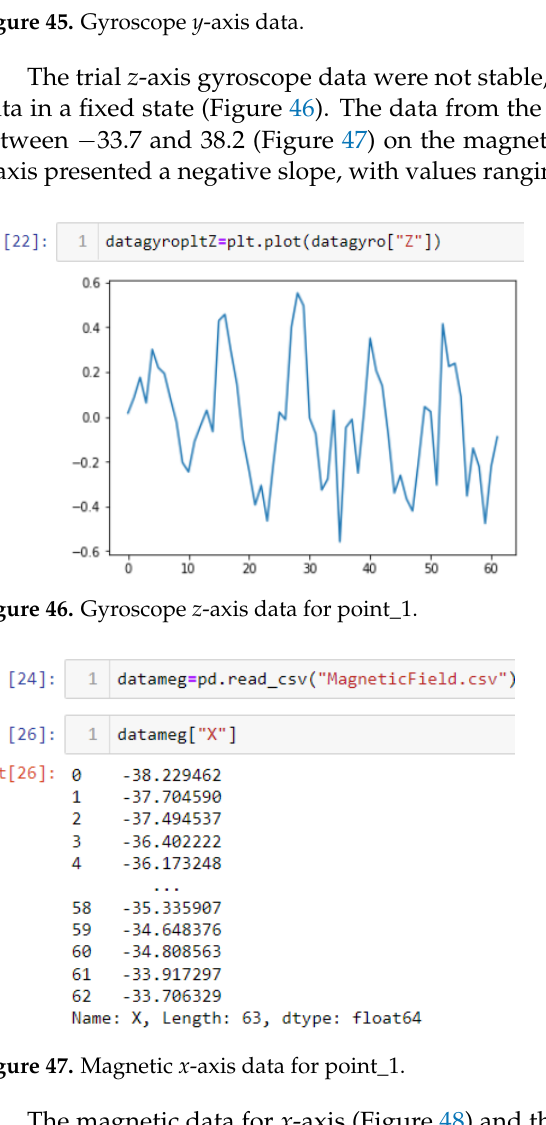
Figure 45. Gyroscope y -axis data.